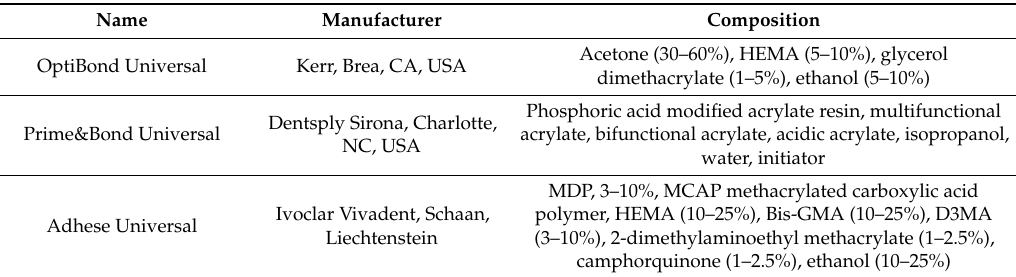
Table 1. Dental bonding